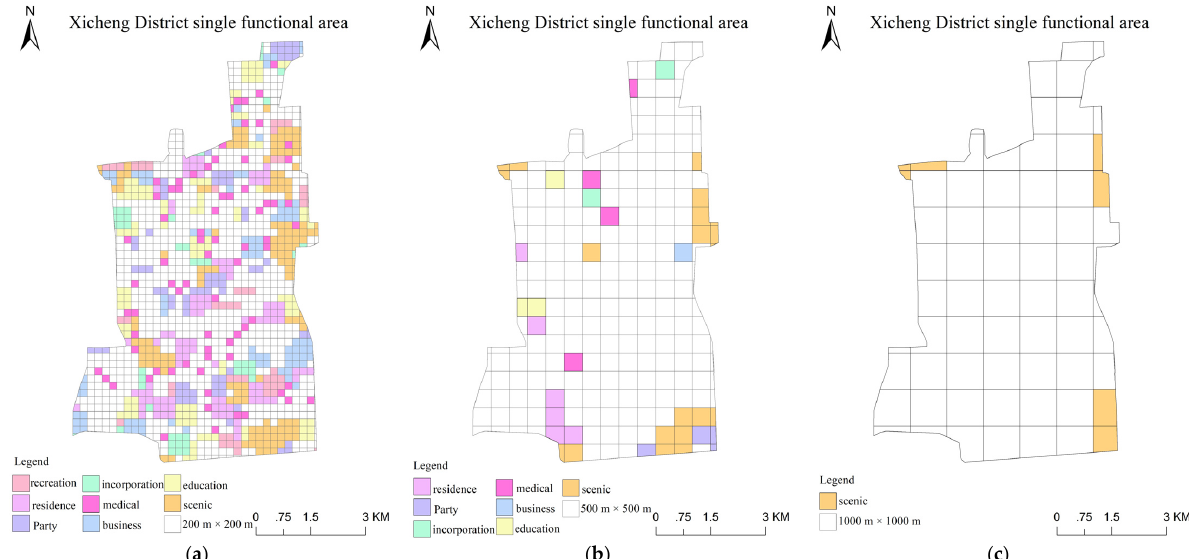
Figure 8. Single-functional areas in the Xicheng District: recreation stands for recreation and entertainment areas; residence stands for residence areas; party stands for party and government organization areas; incorporated stands for incorporated business areas; medical stands for medical and public health areas; business stands for commercial and financial areas; education stands for education and training areas; and scenic stands for scenic areas.